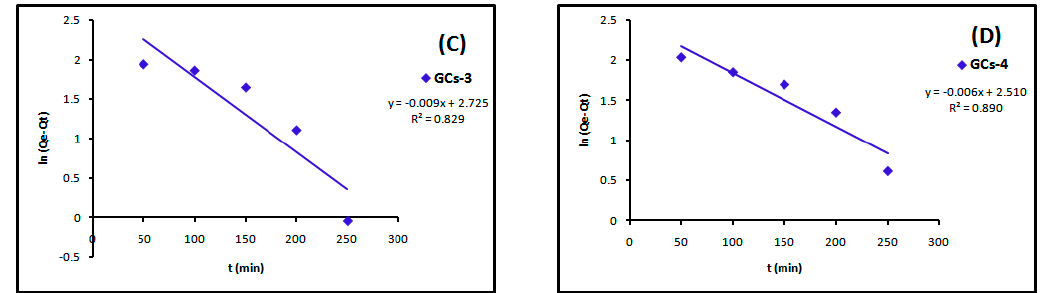
Figure 14. Pseudo-second order kinetics models of copper adsorption using ( A ) GCs-1, ( B ) GCs-2, ( C ) GCs-3 and ( D ) GCs-4.